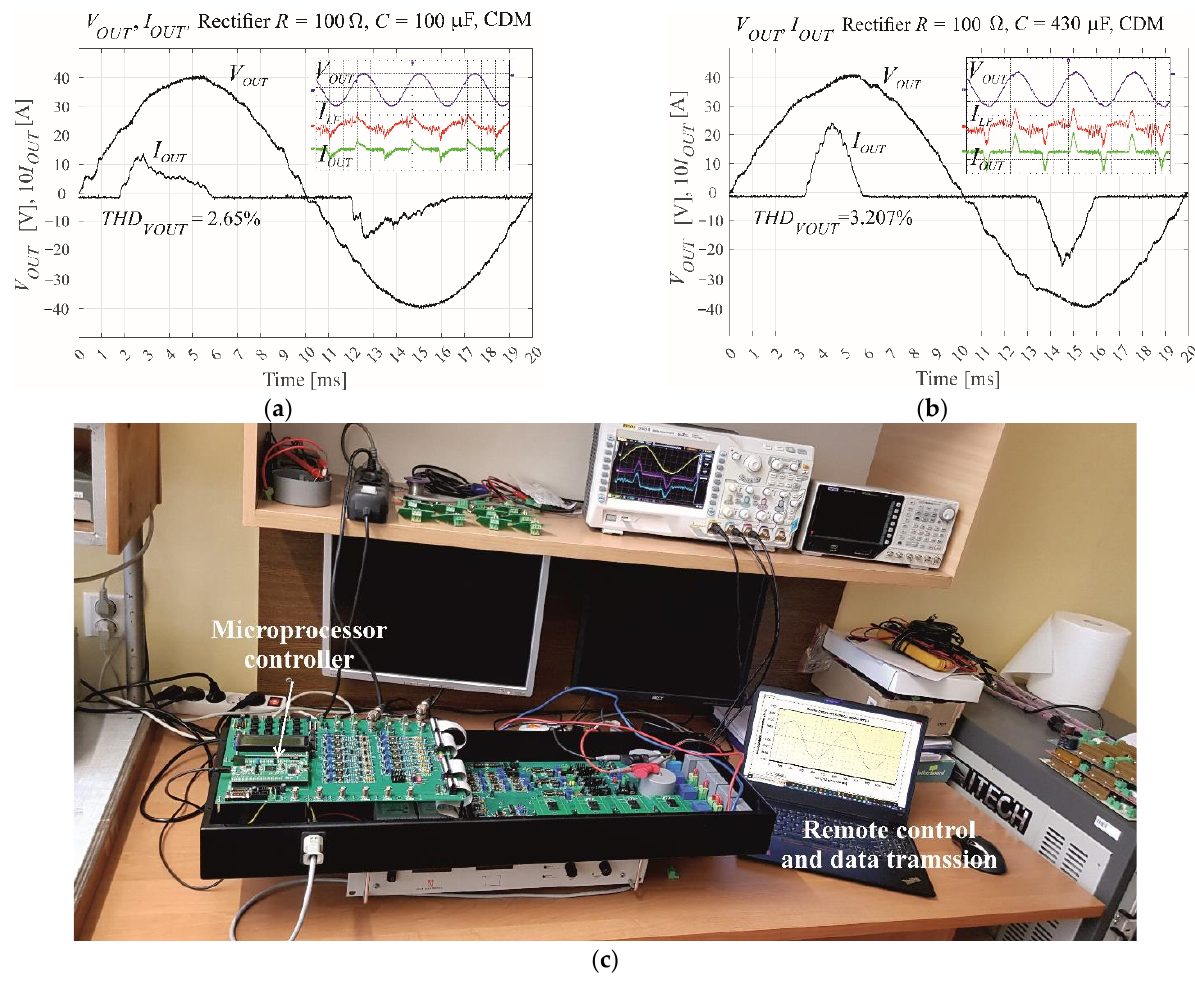
Figure 8. Waveforms of the output voltage, output current, inductor current and measurement of the output voltage THD for CDM and ( a ) a nonlinear rectifier RC load with R =100 Ω, C = 100 μF, and M = 0.6, and ( b ) a nonlinear rectifier RC load with R =100 Ω, C = 430 μF, and M = 0.6, in addition to ( c ) an image of the experimental environment showing the VSI and the microprocessor control- ler.